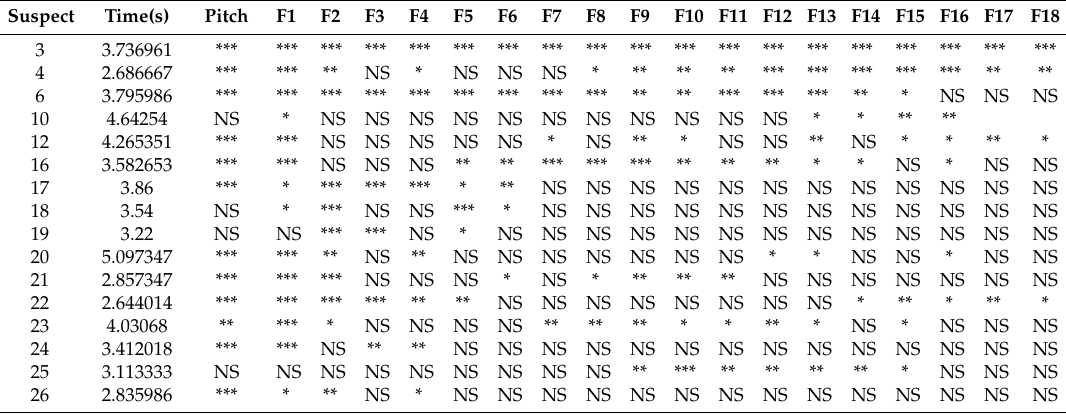
Table 4. The results of the confrontation between the suspects (Sentence #1) and reference (Sentence #1). Suspect Time(s)